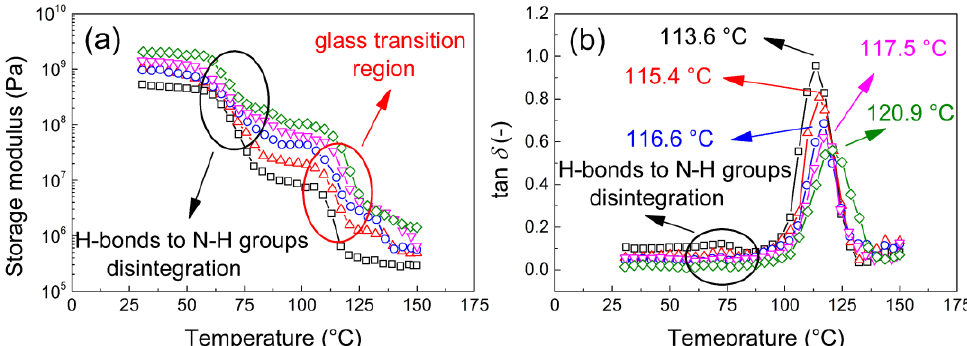
Figure 13. Temperature dependence of the ( a ) storage modulus and ( b ) tan δ of various composite thin films, including neat coPA (black squares), 0.5 wt. % MXene composite (red triangles), 1 wt. % MXene composite (blue circles), 2.5 wt. % MXene composite (magenta downward triangles) and 5 wt. % MXene composite (green diamonds).